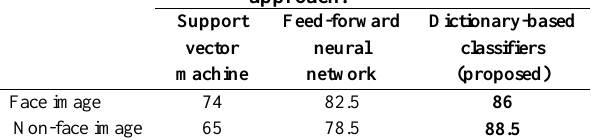
Table 4. Accuracy percentages of face/non-face image classifier based on the magnitude and phase of the Gabor coefficients for different classifiers and the proposed approach.